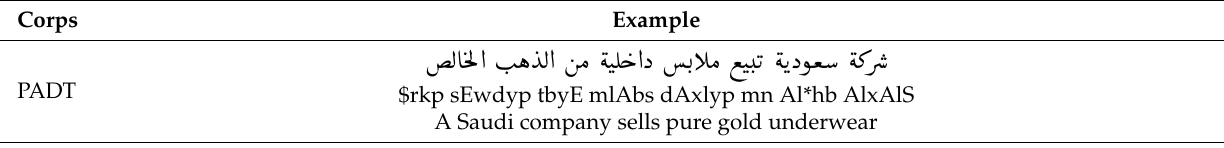
Table 16. Sample of degenerated test examples in PADT and ArPoT. Each example presented the original sentence in Arabic, its transliteration, and its translation in English. (cid:9) (cid:145)(cid:203)(cid:65)(cid:9) (cid:109)(cid:204)(cid:39)(cid:64) (cid:16) (cid:16) (cid:16) (cid:233)(cid:187)(cid:81)(cid:229)(cid:17) (cid:9) (cid:16) (cid:73) (cid:46) (cid:235) (cid:89)(cid:203)(cid:64) (cid:9)(cid:225)(cid:211) (cid:233)(cid:74) (cid:10) (cid:202) (cid:103)(cid:64)(cid:88) (cid:129)(cid:29) (cid:46) (cid:67)(cid:211) (cid:169)(cid:74) (cid:10) (cid:28) (cid:46) (cid:75) (cid:233)(cid:75) (cid:10) (cid:88)(cid:241)(cid:170)(cid:131)